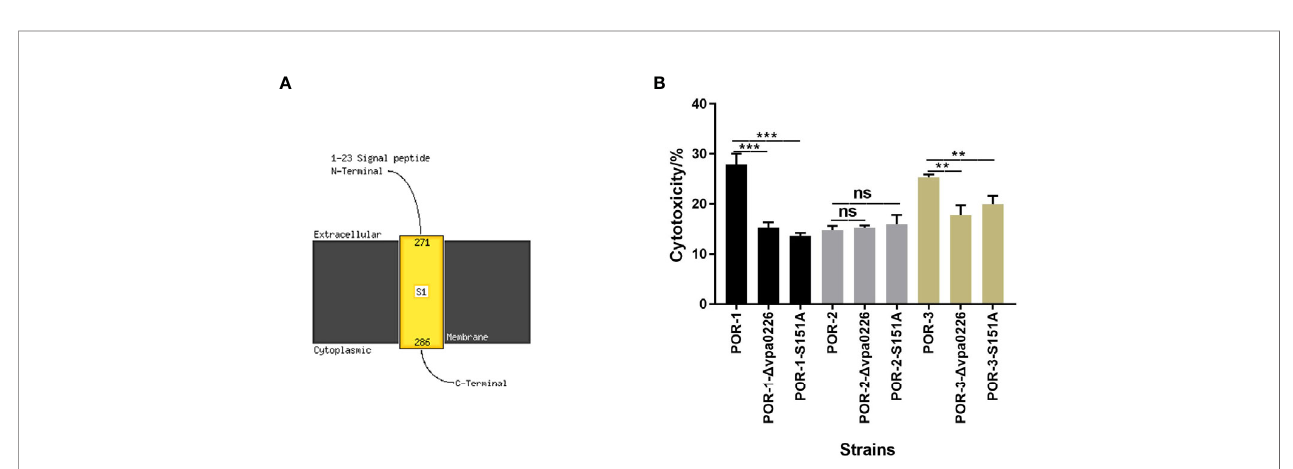
FIGURE 5 | VPA0226 is secreted by T3SS1. Intracellular cAMP levels were quanti fi ed after infection with V. parahaemolyticus POR-1, POR-2, and POR-3 strains, which harbored pMMB207-vpa0226-CyaA, pMMB207-vp1683-CyaA, and pMMB207-vp1686-CyaA, respectively (A) . Intracellular translocated amounts of CyaA- fused protein were also examined after infection with V. parahaemolyticus POR-1, POR-2, and POR- 3 strains harboring the pMMB207-vpa0226-CyaA expression vector. GAPDH served as internal reference. “ + ” or “ - ” refers to a strain harboring pMMB207-vpa0226-CyaA expression vector (+) or not (-) (B) . Densitometry analysis of B was performed for relative quanti fi cation (C) . Secretion of VPA0226 (supernatant) from POR-1, POR-2, POR-3 and D vcrD1 / vcrD2 strains harboring the pMMB207-vpa0226-CyaA vector were detected by immunoblotting with anti-CyaA antibody (D) . Loading control served as total bacterial lysate or total secretion media, LE, Long exposure; SE, Short exposure. Densitometry analysis of SE and LE were respectively performed for relative quanti fi cation, as shown in (E, F) E (the supernatant of SE): the CyaA/Control (intensity band ratio) of POR-1, POR-2, POR-3 and D vcrD1 / vcrD2 is 4.47 (60725/13565), 3.51 (43948/12494), 6.00 (77525/ 12919), and 2.98 (30288/10145), respectively. F (the supernatant of LE): the CyaA/Control (intensity band ratio) of POR-1, POR-2, POR-3 and D vcrD1 / vcrD2 is 9.11 (123677/13565), 7.39 (92309/12494), 12.48 (161263/12919), and 6.54 (66395/10145), respectively. F (the pellet of LE): the CyaA/Control (intensity band ratio) of POR-1, POR-2, POR-3 and D vcrD1 / vcrD2 is 0.09 (2362/27281), 0.18 (6382/34193), 0.07 (1788/25424) and 0.21 (5996/28786), respectively. **** P < 0.0001, *** P < 0.001, ** P < 0.01, and * P < 0.05.